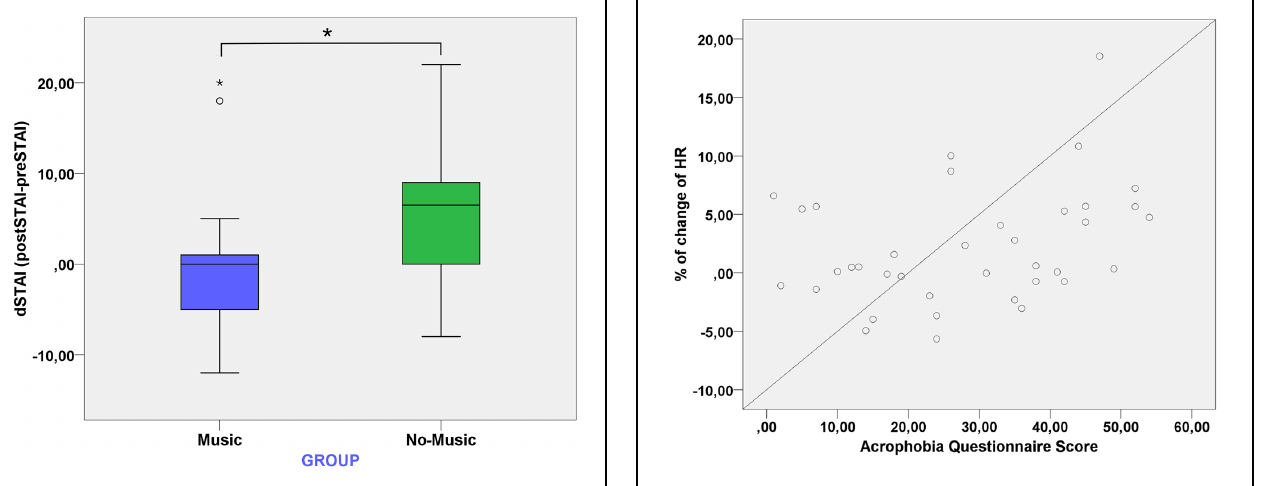
FIGURE 4 | Boxplot of dSTAI, which is the difference between the post-assessment STAI and the pre-assessment STAI, between the music and no-music conditions.